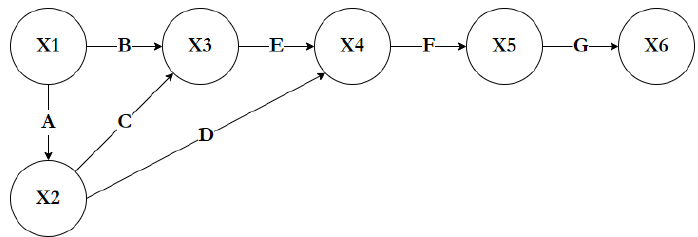
Figure 4. Process representation.